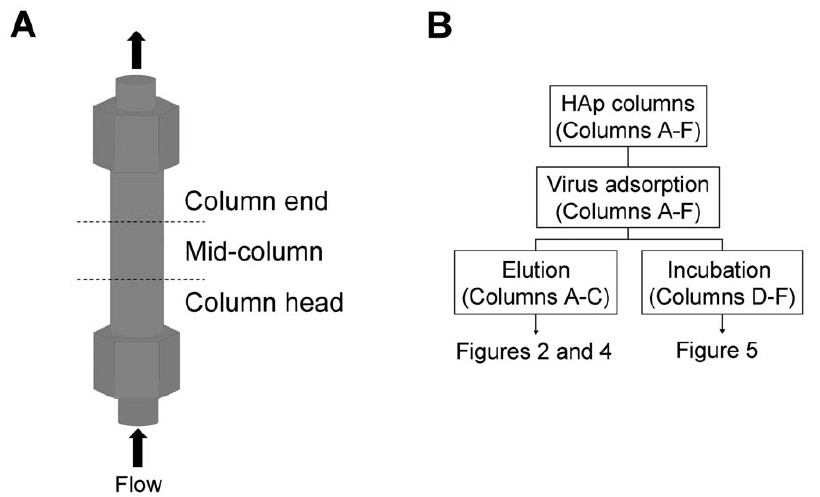
Figure 1. Illustration of experimental methods. A: The flow direction and the division of the hydroxyapatite (HAp) column into 3 parts. After removing the HAp particles from the column, HAp particles were collected in each part of the column. Column head: lower position of the column (upstream side); Mid-column: middle position of the column; Column end: upper position of the column (downstream side). B: Virus elution and incubation processes of HAp columns. Detailed conditions are described in the Materials and methods, section